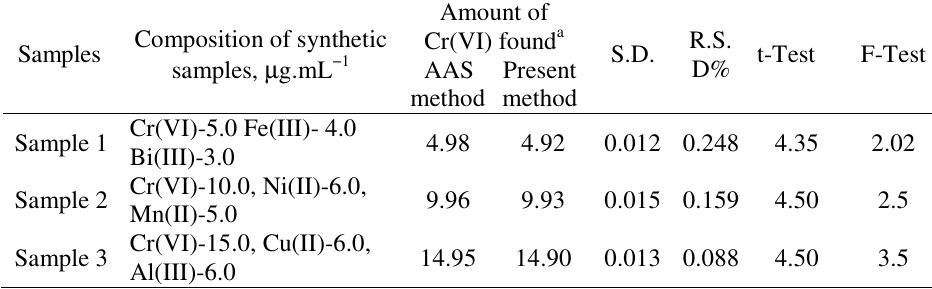
Table 2. Determination of chromium(VI) in water samples.